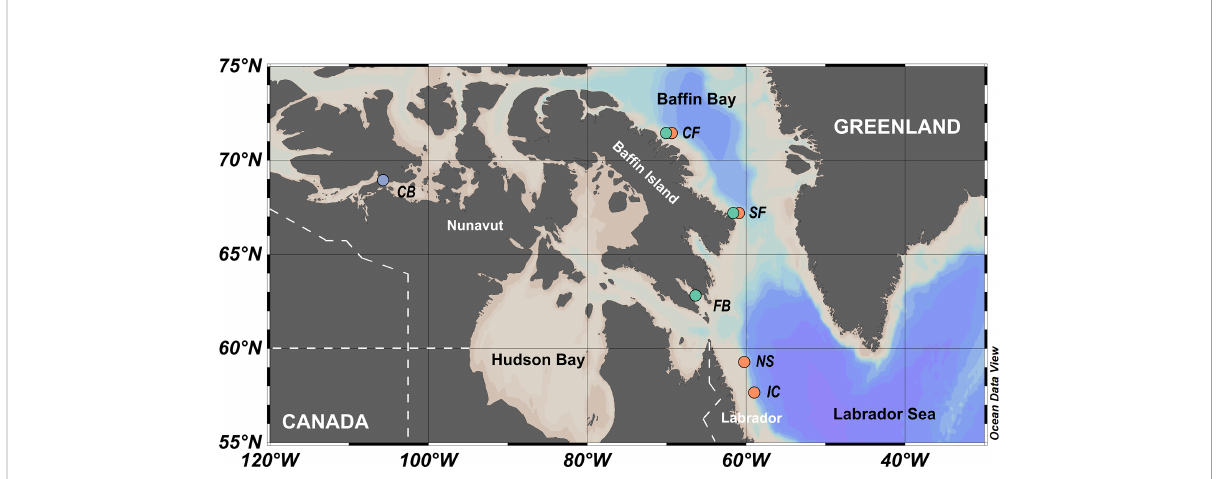
FIGURE 1 Map of sampling locations off Labrador and Nunavut, Canada. Light blue circles: sea ice algae collected by coring of spring fast ice; Green circles: sea ice algae collected by melting of late spring and early summer brash ice; Orange circles: pelagic algae collected by a CTD-Rosette. Location/station abbreviations: CB, Cambridge Bay; CF, Clark Fjord; SF, Southwind Fjord; FB, Frobisher Bay; NS, Non-sponge Site; IC, ISECOLD1-1500. Figure made with Ocean Data View , (Schlitzer,